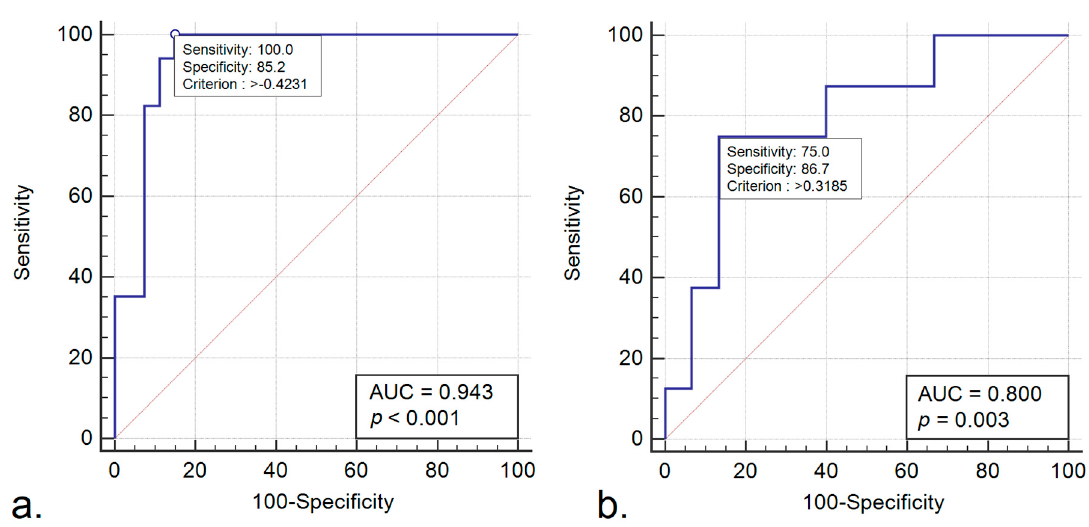
Figure 3. ( a ). Receiver operating characteristic (ROC) curve of the radiomics score for predicting locally advanced rectal cancer (LARC) non-responders—training set. ( b ). ROC curve of the radiomics score for predicting LARC non-responders—validation set. Table 3. Individual diagnostic performance of the selected radiomics features.